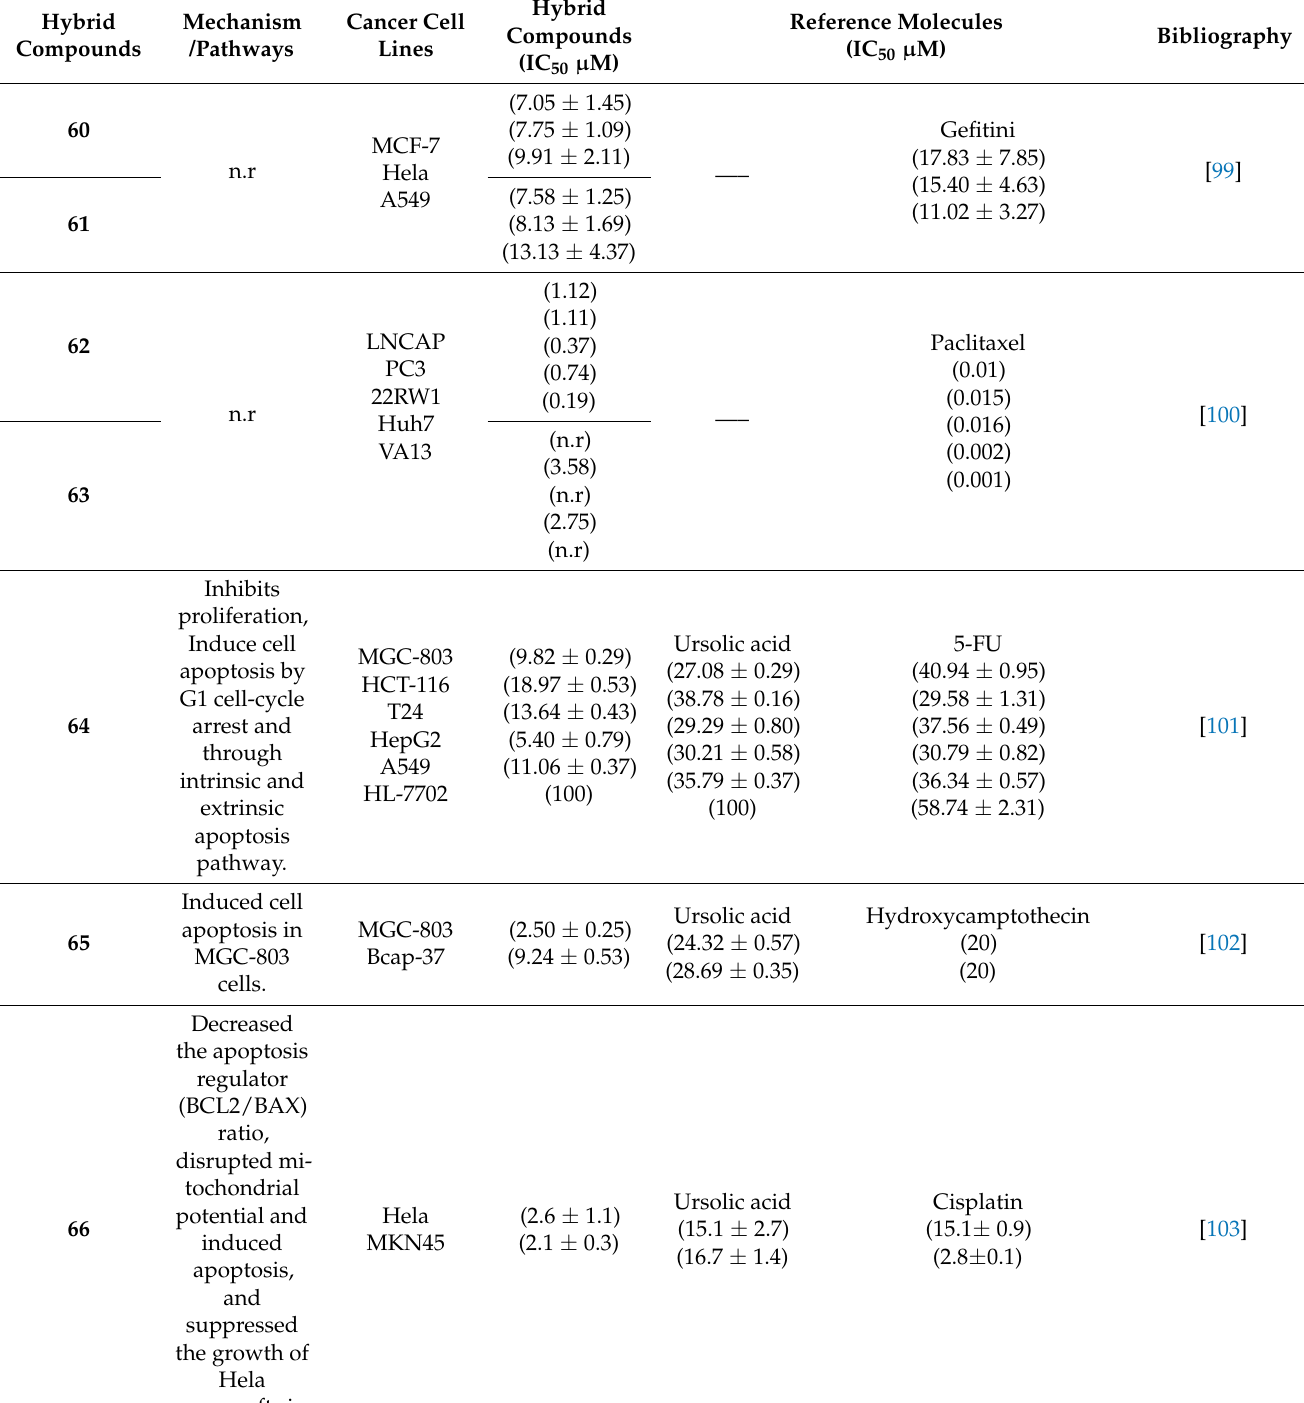
Table 3. Mechanism and cytotoxicity of PT-based piperazine scaffolds on different cancer cells.